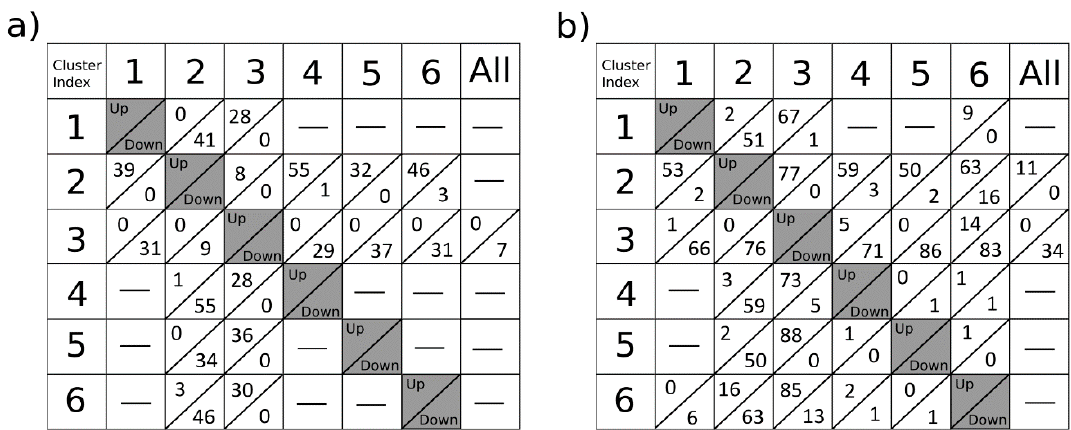
Figure 2. Number of up or down-regulated ions associated with the comparison of one particular cluster with each of the others (columns 1 to 6) and the ions that are up-regulated (or down-regulated) in a cluster as a result of the comparison between this cluster and the rest of clusters, called “absolutely up-regulated ions” (or “absolutely down-regulated ions”). The image is composed by 6898 pixels and the number of detected ions is 277. The percentile value used for the selection of the ions is 1% for the null concentration parameter (Z) and 10% for the Mann–Whitney U (V) test and for the concentration fold change (FC). The intensity threshold for the ions is 2.5 × 10 − 4 over the normalized spectra matrix. The small lack of symmetry observed in the table is a consequence of the lack of symmetry in the distributions considered. In ( a ), the up-down regulated ions are calculated following the classical procedure, while in ( b ) the ions are calculated according the procedure described in section methods, that considers that the null values are not taken into account.